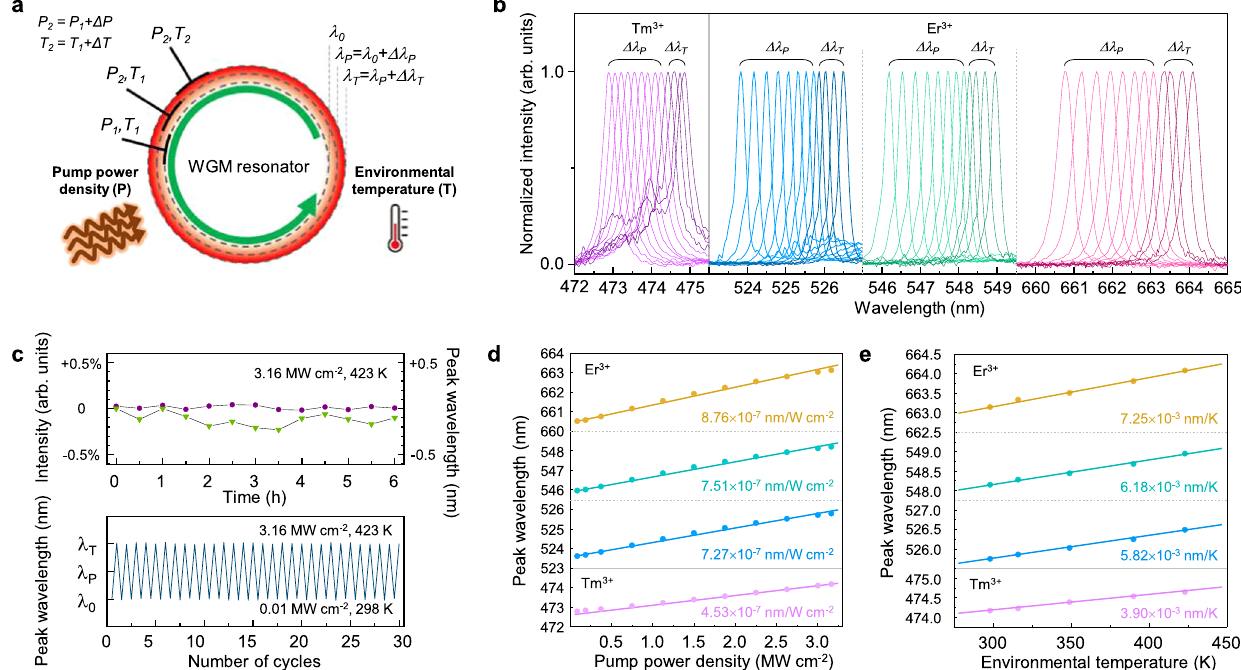
Fig. 6 Tuning of laser emission wavelengths. a Schematic of wavelength tuning achieved by controlling the pump power density ( Δ P ) and operation temperature ( Δ T ). The initial lasing wavelength and the shifted lasing wavelengths under the control of the pump power density and operation temperature are indicated by λ 0 , λ P and λ T , respectively. b Emission spectra of spectrally tuned lasers. Δ λ P and Δ λ T indicate shifts in the lasing wavelength with increasing pump power density (from 0.01 to 3.16 MW cm − 2 ) and operation temperature (from 298 to 423 K). c Stability analysis in terms of static (above) and dynamic (below) operations. Green and purple lines in static operation indicate the lasing peak intensity and spectral position depending on time, respectively. d , e Linear plots of the laser line peak wavelengths as a function of pump power density ( d ) and operation temperature ( e